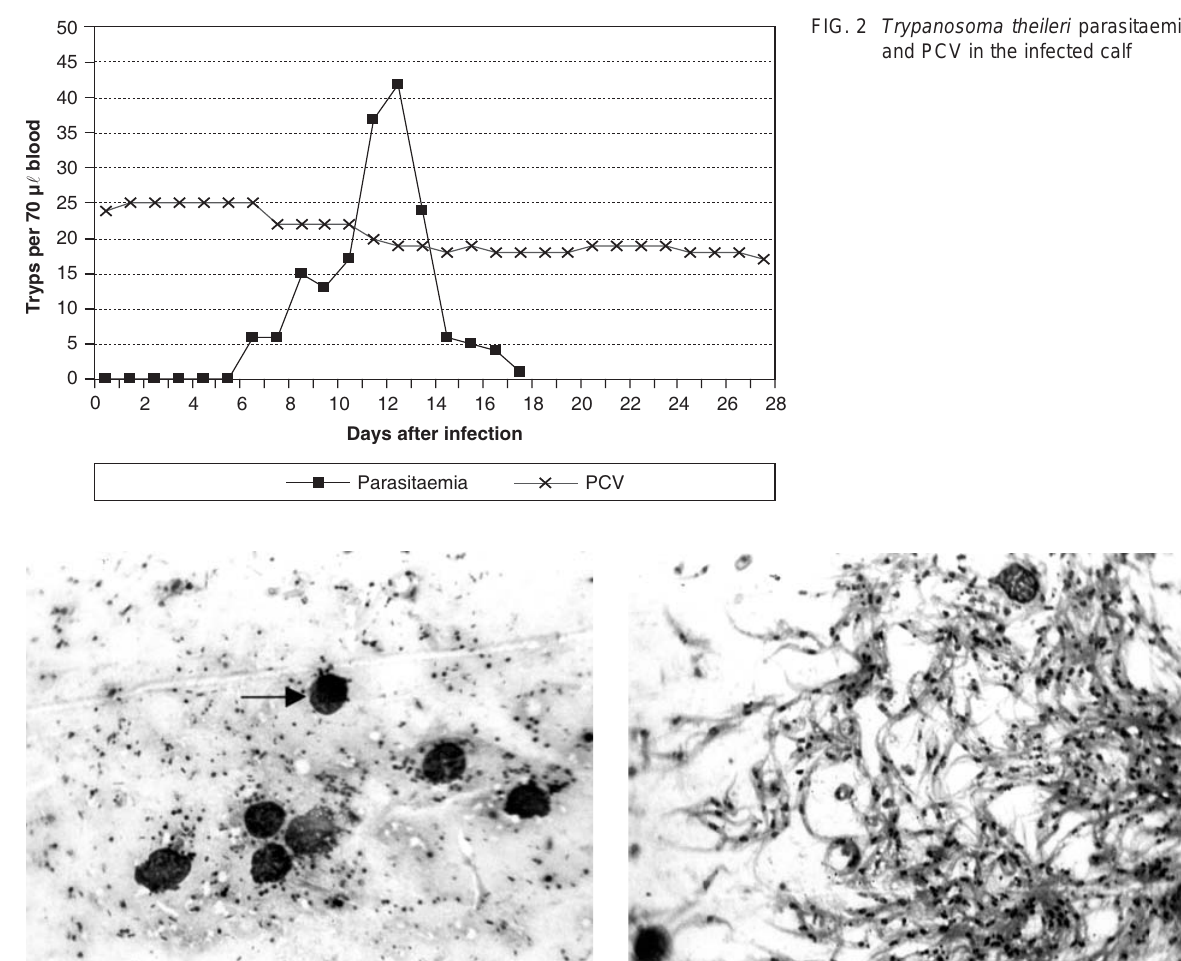
Infection rates of Hyalomma anatolicum anatolicum with Trypanosoma theileri